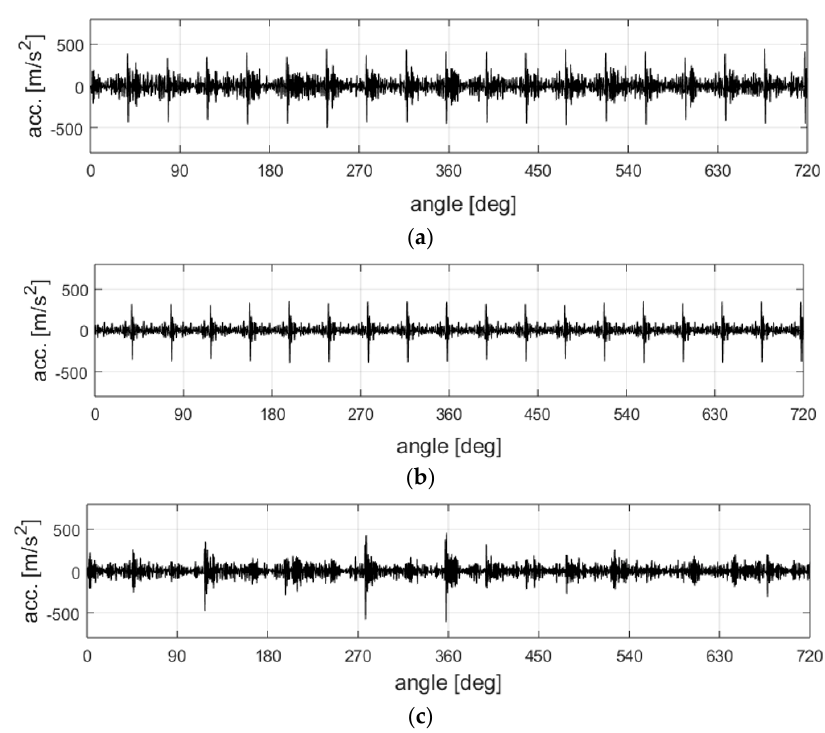
Figure 3. ( a ) Raw signal, ( b ) synchronous average, and ( c ) residual signal for the signal acquired with sensor 1 in the case of the flawless pump (1500 r/min, 150 bar).